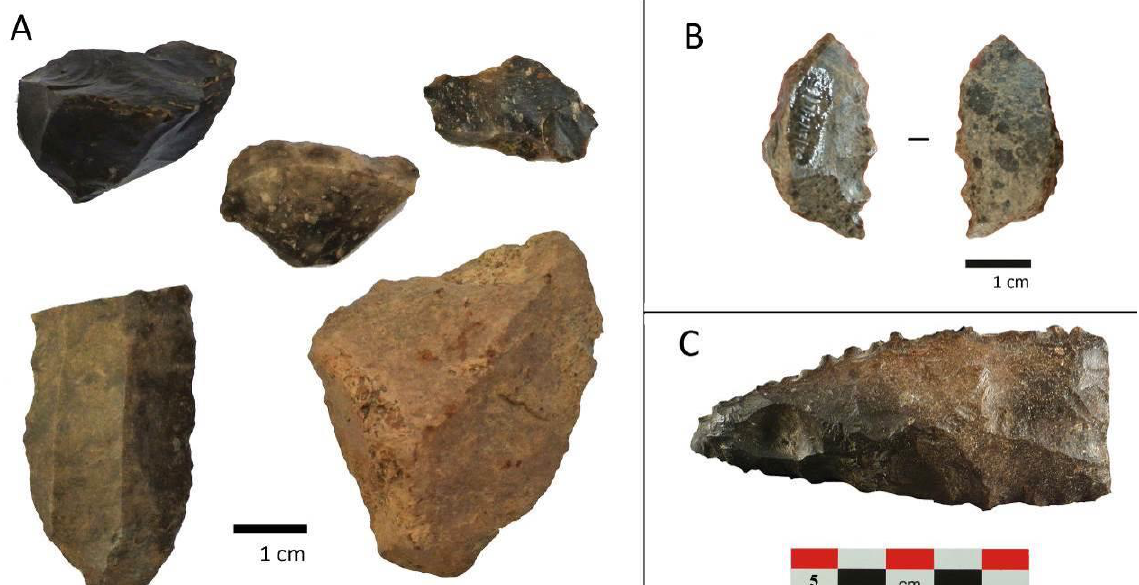
Figure 16. Proposed Mucientes chert (hand specimen identification) from archaeological sites at León. A: Objets from Las Choperas (Santas Martas). B: Sickle tooth from Los Palomares (Fontanil de los Oteros). C: Denticulated foliate from Los Villares (Valderas, Photo: J. L.